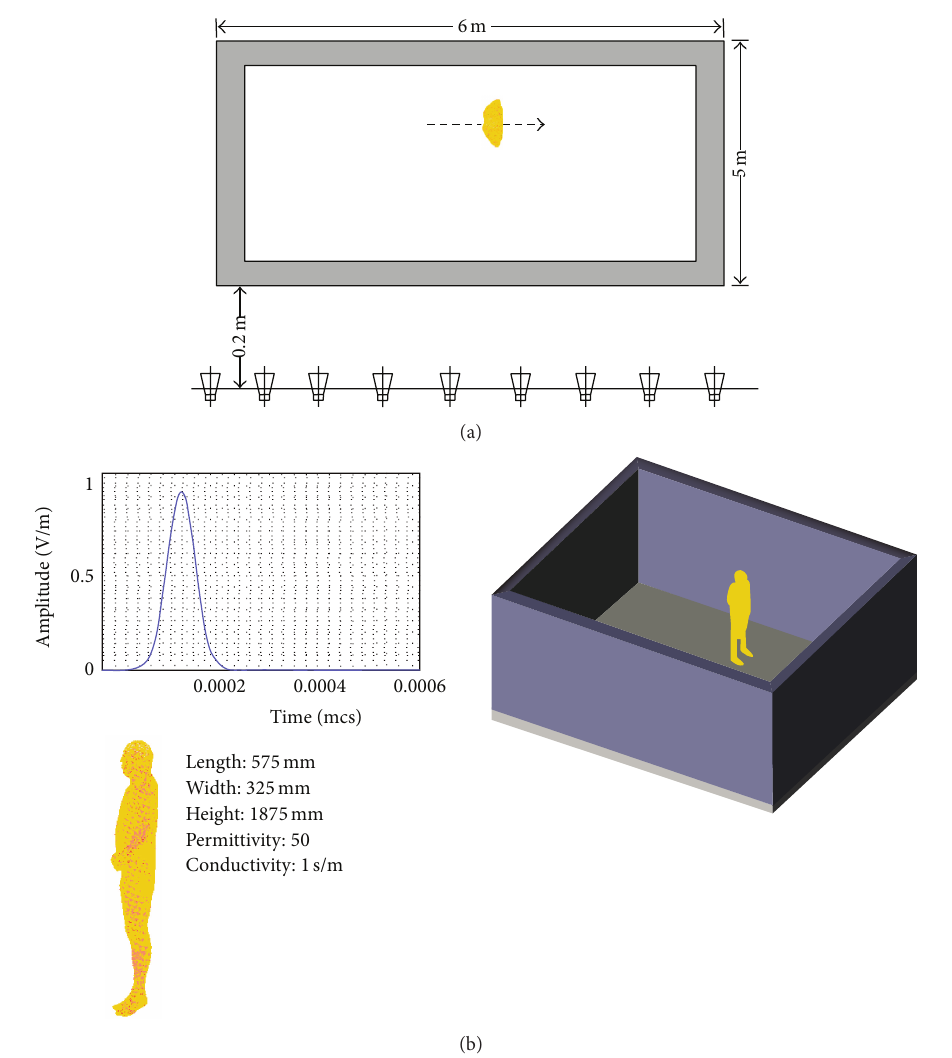
Figure 17: Simulation scene and 3D model. (a) A human moves in a four-wall room in monostatic through-the-wall mode. (b) Top: 3 GHz band impulse signal in the time domain; left-bottom: the human model used in the simulation; right-bottom: 3D model of the